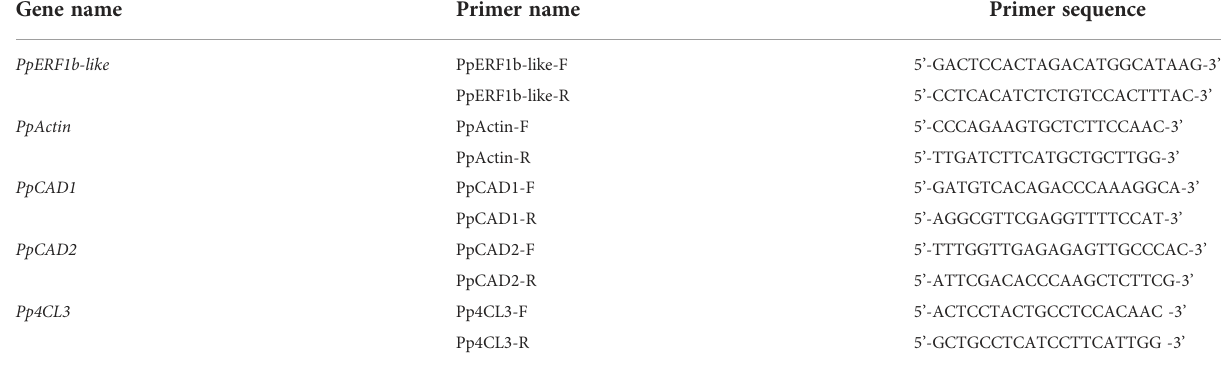
TABLE 1 Primers used for RT-qPCR